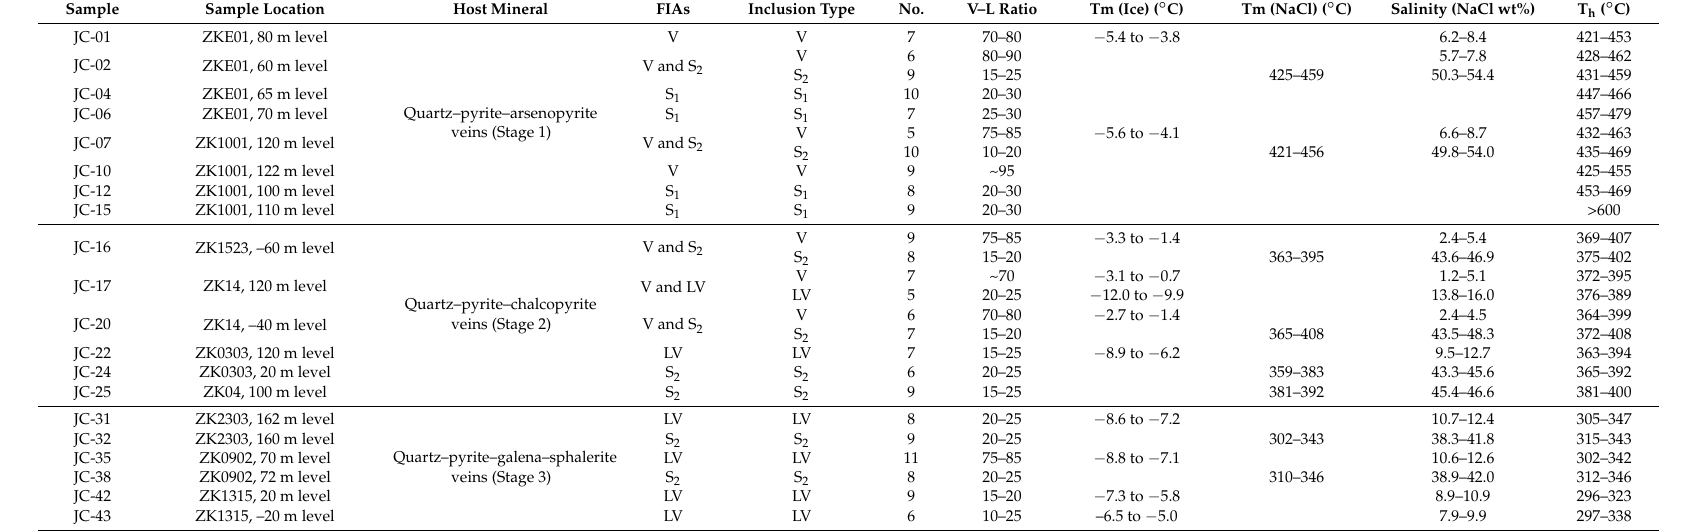
Table 1. Microthermometric data for fluid inclusions in hydrothermal quartz of the Jinchang